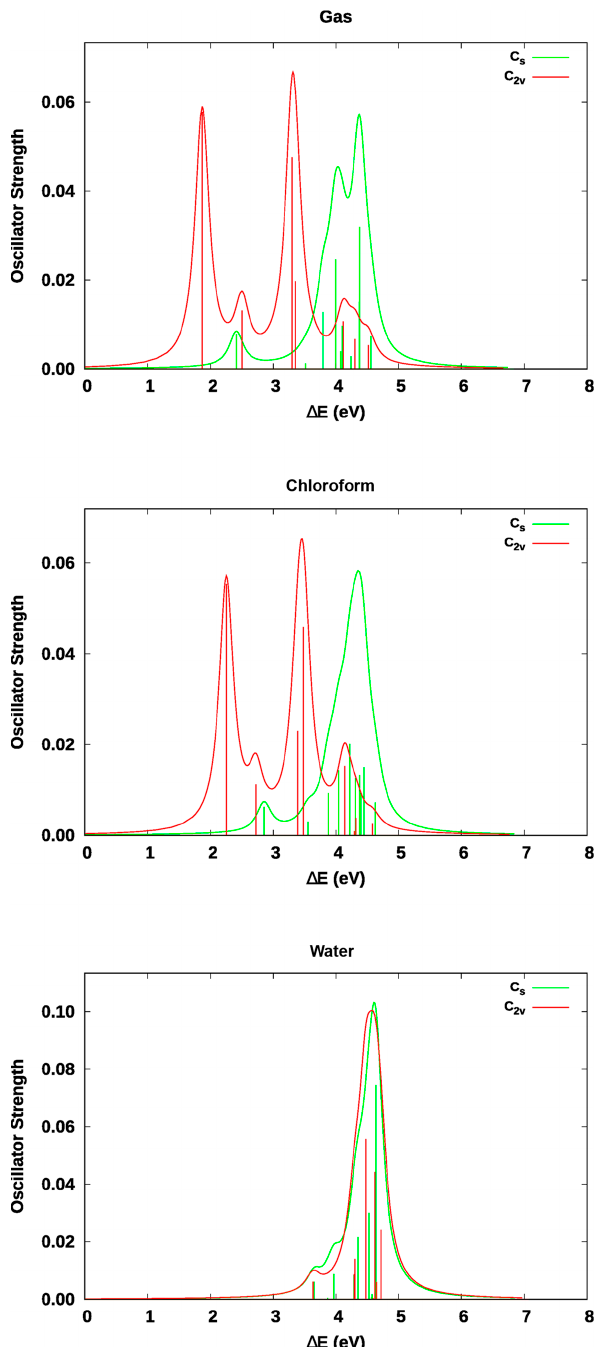
Figure 3. Absorption spectra of the C s conformer in the gas phase and solution. For comparison, the corresponding results for the C 2v conformer (taken from Ref. [16]) are included.